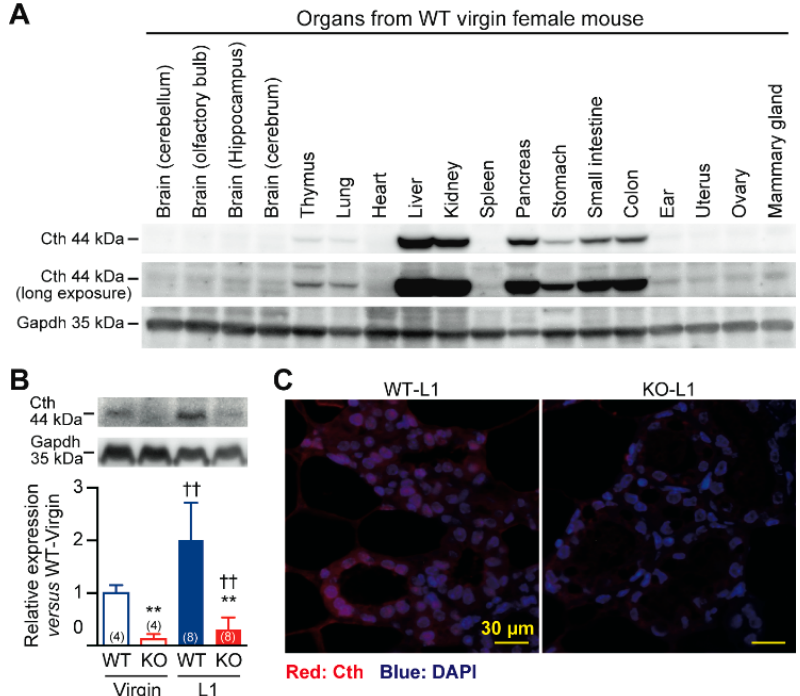
Figure 5. Cth expression in the mammary gland. ( A ) Western blot analyses of Cth expression in various tissues of wild-type (WT) virgin female mice. The 44 kDa Cth proteins (short and long exposures) and 35 kDa Gapdh proteins (as controls) are shown. ( B ) Cth expression in the mammary glands of the virgin/lactating day 1 (L1) WT and Cth − / − (KO) mice. The 44 kDa bands in KO tissues are non-specific. Data are mean ± SD ( n in parentheses) and significant differences were observed versus WT at ** p < 0.01 and versus virgin at †† p < 0.01. ( C ) Cth immunostaining ( red ) of mammary gland sections. The nuclei were stained with DAPI (blue). Bars are 30 µm.